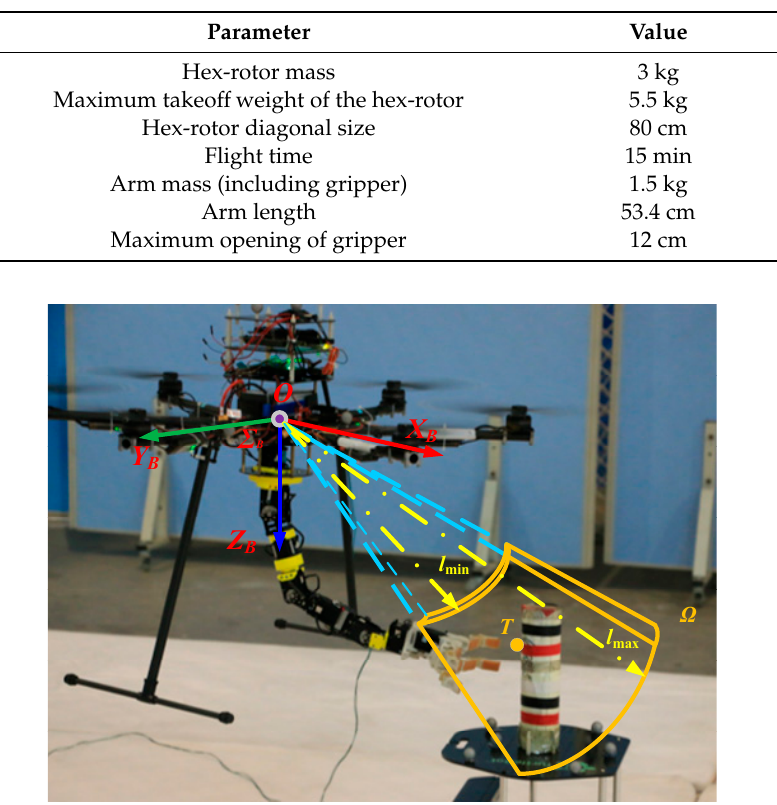
Figure 5. Operational space of aerial manipulator.